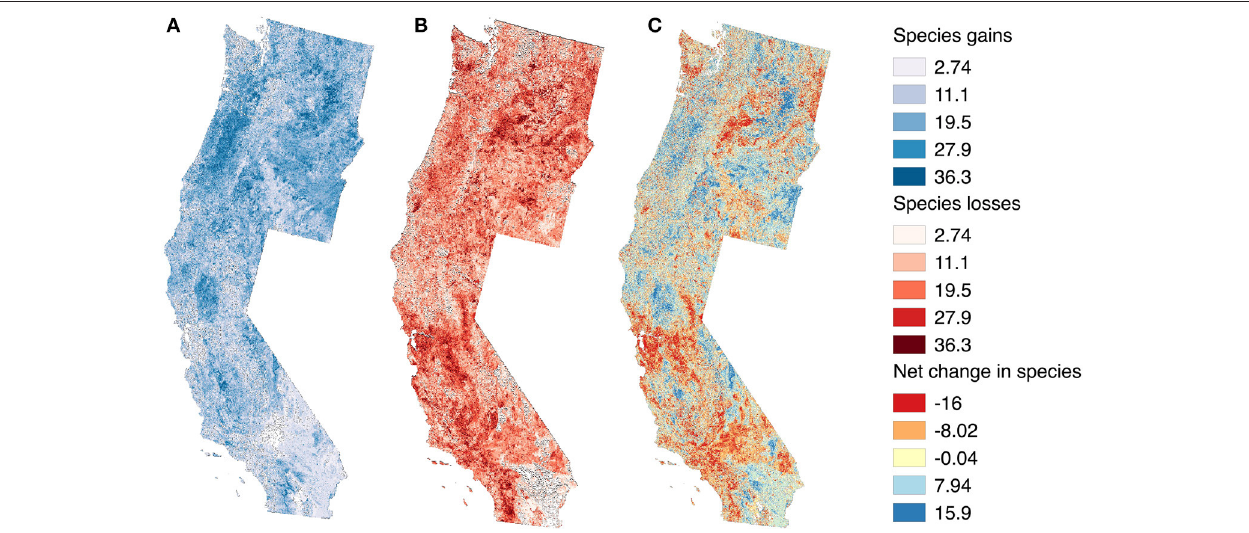
FIGURE 5 | Stacked (summed) regional trend maps showing “hotspots” for (A) number of species declining, (B) number of species increasing, and (C) net numbers of species increasing or decreasing across all species with statistically significant correlations between predicted and observed abundance changes. Hotspots for declines tended to be associated with decreases in precipitation, whereas hotspots for population increases were associated with increases in Landsat band 4—a reflectance associated with recovery from disturbance and deciduous